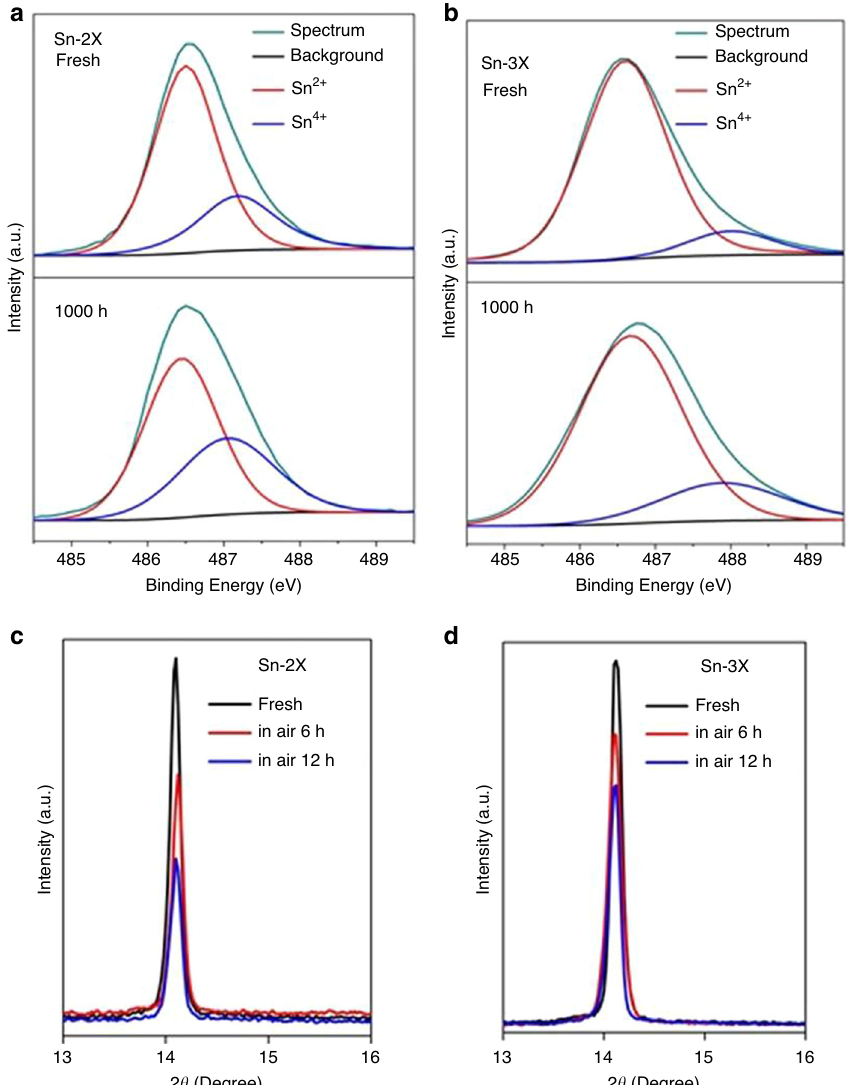
Fig. 2 The characterization of the stability of tin perovskite layers. a High-resolution XPS spectrum of the Sn 3 d 5/3 region of Sn-2X and b Sn-3X fi lm before (top) and after (bottom) being exposed to continuous simulated sunlight AM 1.5 G (100 mW cm − 2 ) for 1000 h, respectively. The normalized intensity of the (100) peak in XRD patterns of c Sn-2X and d Sn-3X fi lms as a function of time in ambient